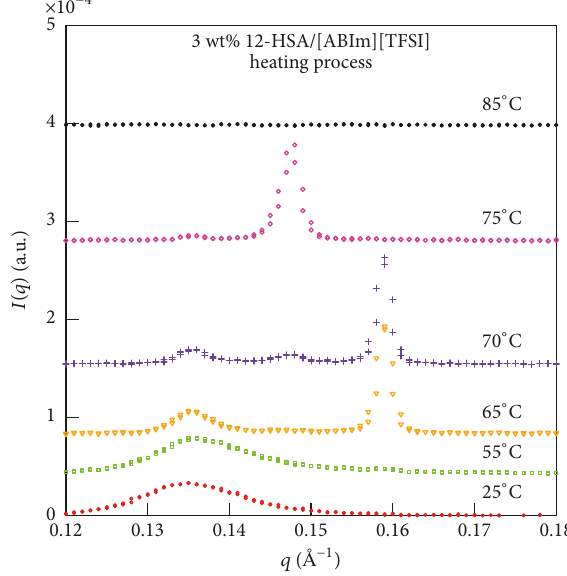
Figure 9: SAXS profiles of 3 wt% 12-HSA/[ABIm][TFSI] gel at various temperatures in a stepwise heating process. Profiles are vertically shifted for visual